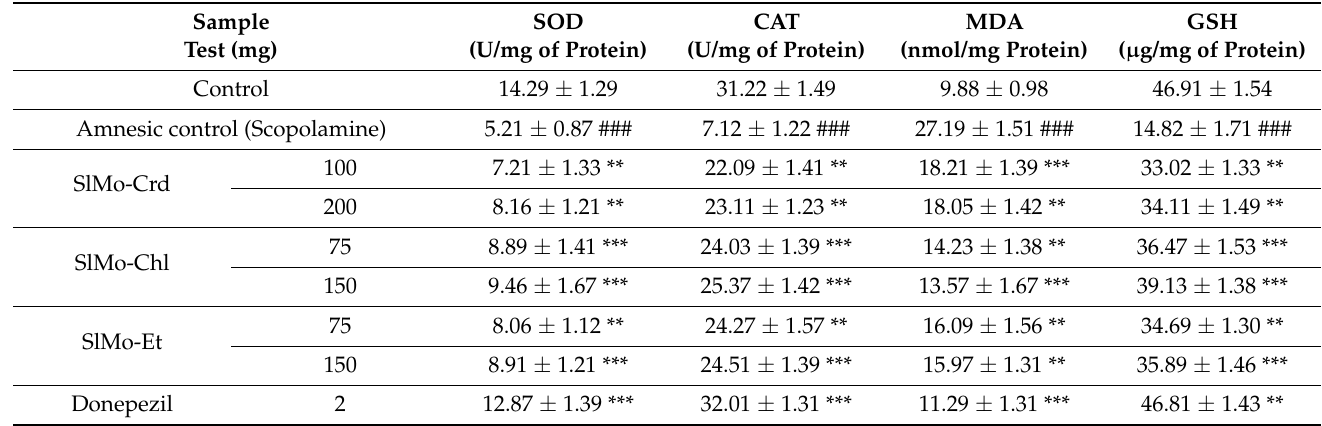
Table 4. Effects of extracts on different biomarker levels in brain of